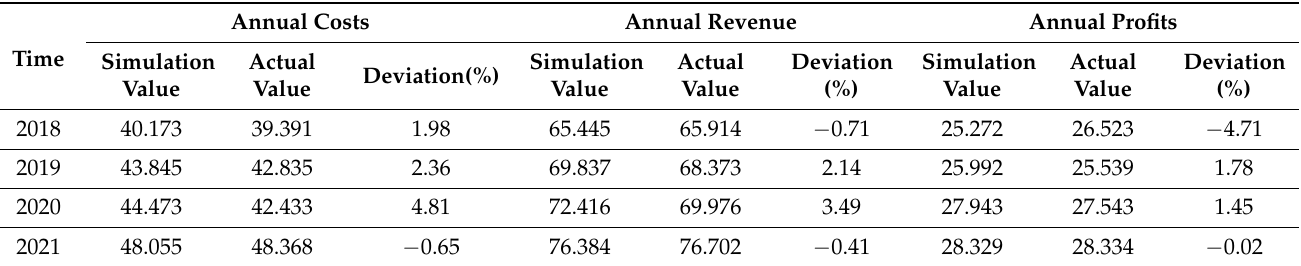
Table 3. Authenticity